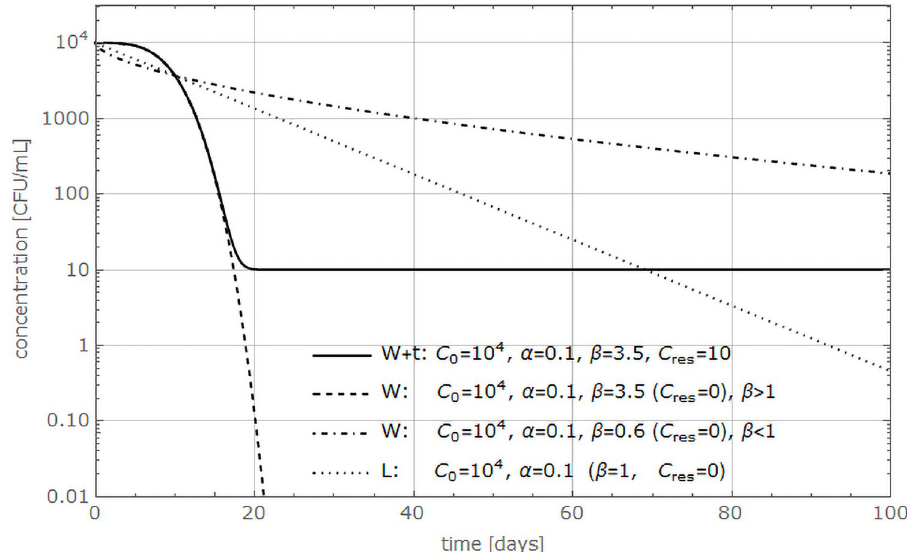
Fig 2. Die-off models. Different die-off models were simulated with given parameter estimates (see values in the graph). The pathogen concentration in CFU/mL is plotted against time in days. W+t stands for Weibull + tail, W for Weibull, and L for log-linear